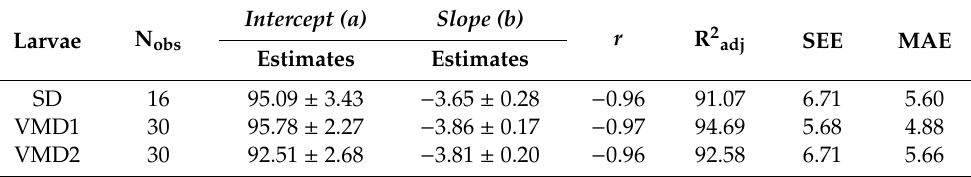
Table 2. Results of the regression analysis of percent residue weight (Wr) vs. drying time.